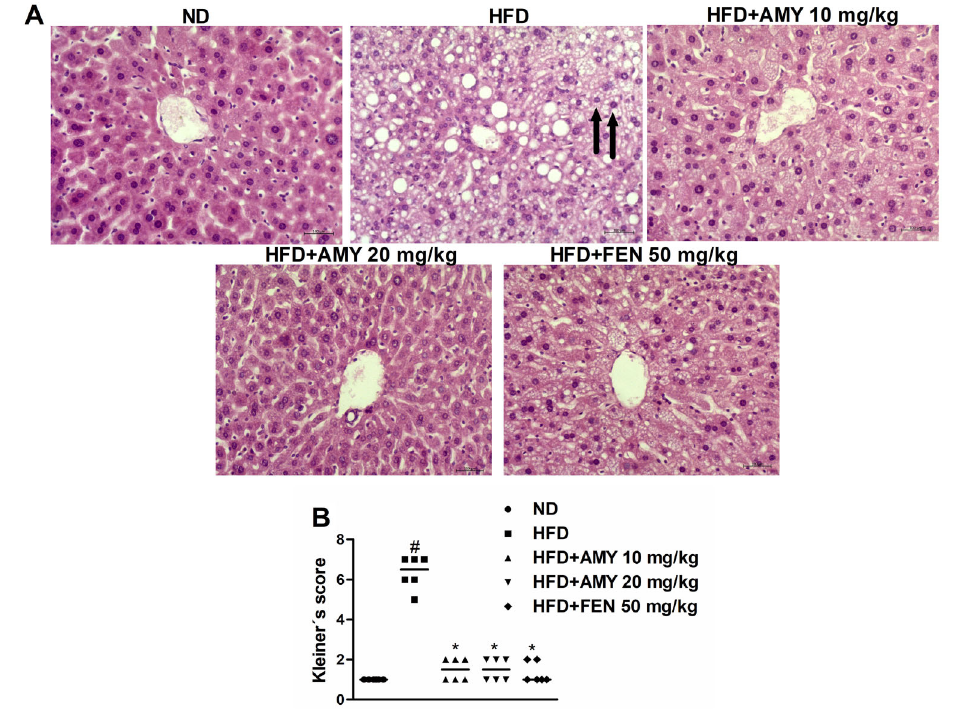
Figure 3. A , Representative liver sections (H&E stained) from ND-fed group, HFD-fed group, HFD + AMY (10 mg/kg), HFD + AMY (20 mg/kg), and HFD + FEN (50 mg/kg) (magni fi cation: 200 (cid:1) , scale bar: 100 m m). Arrows indicate hepatocyte ballooning. B , The Kleiner ’ s score of steatosis, lobular in fl ammation, and hepatocyte ballooning. Data are reported as median values (n=6). # P o 0.05 vs ND-fed animals; *P o 0.05 vs HFD-fed animals (Kruskal-Wallis followed by Dunn ’ s test). ND: normal diet; HFD: high-fat diet; AMY: a , b - amyrin; FEN: feno fi